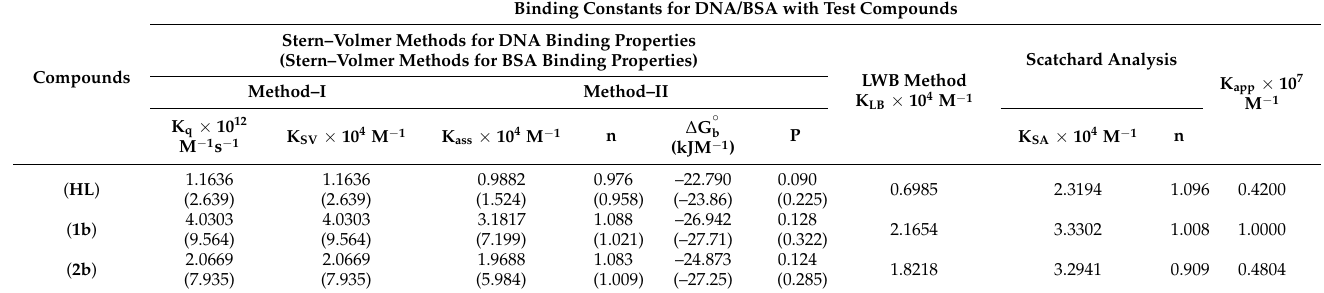
Table 4. The binding constants and binding sites for the interaction of ligand ( HL ) and mixed ligand complexes ( 1b – 2b ) with EB–DNA at pH = 7.4 from ethidium bromide displacement assay by fluorescence spectral